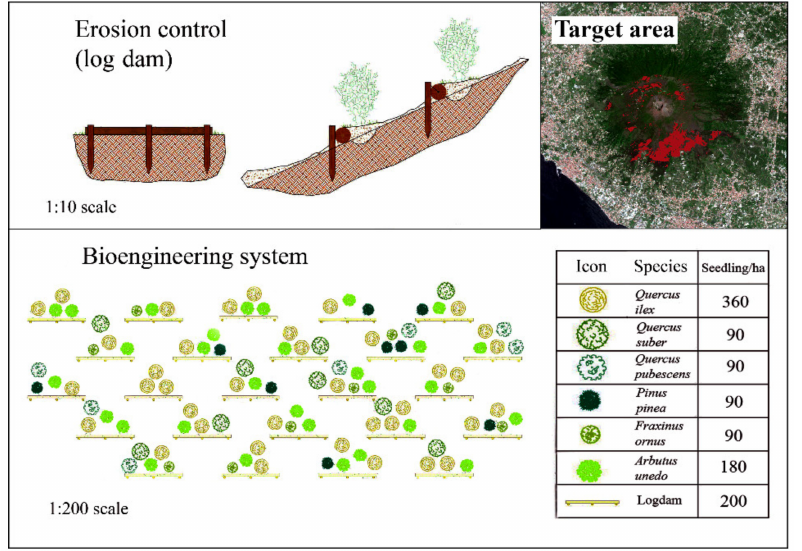
Figure 4. Bioengineering system applied to control the erosion rate, and native shrub and tree species prescribed to re-establish a suitable forest